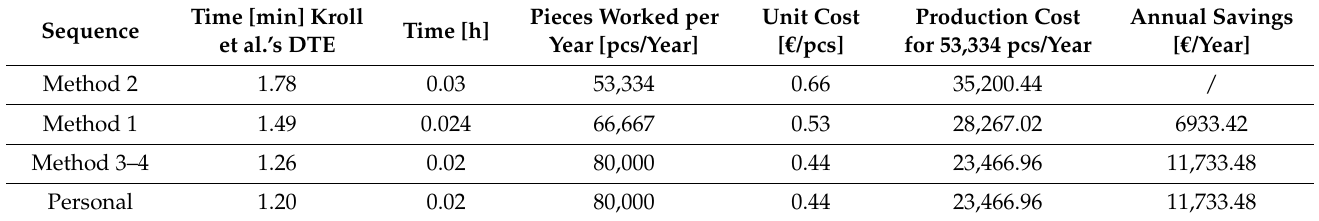
Table 5. Disassembly time estimated (DTE) with the Kroll and Carver